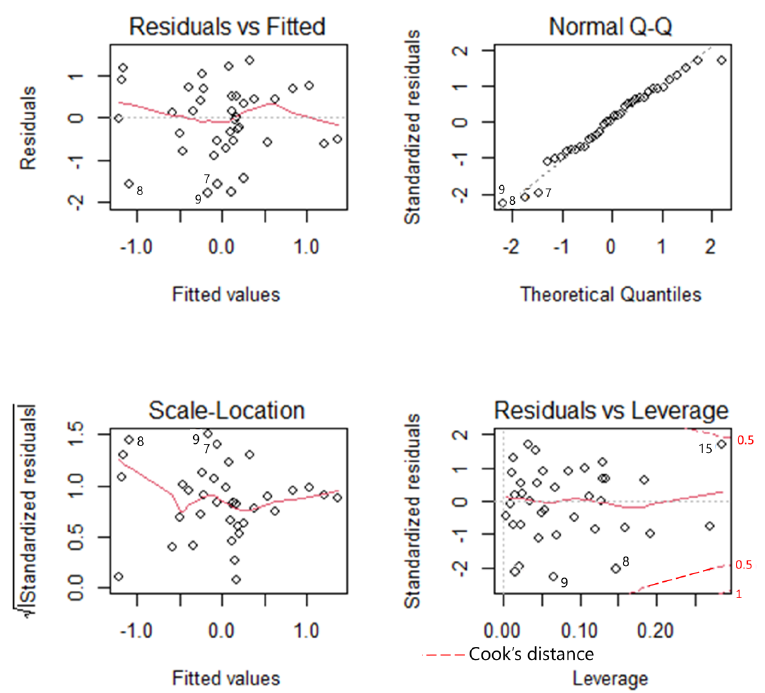
Figure A6. Model diagnostics for the best model with overall spring AA as the explained variable, and 15 climate variables and the Year as explanatory variables for the Common Redstart Phoenicurus phoenicurus (Table